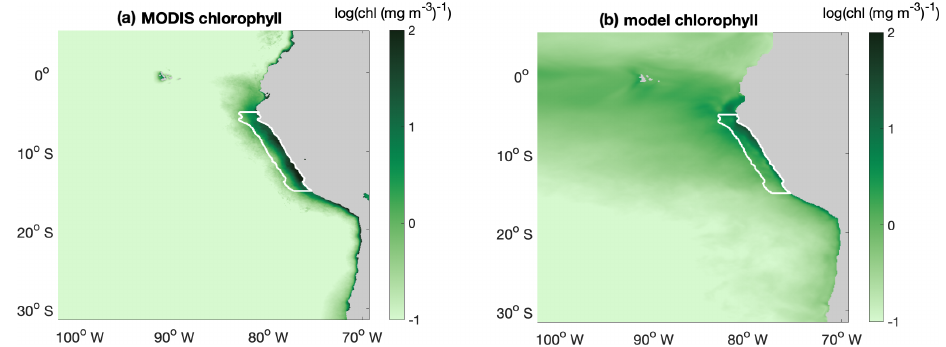
Figure B1. Annual mean surface chlorophyll concentration (in log ( chl ( mgm − 3 ) − 1 )) distribution of (a) MODIS and (b) CROCO–BioEBUS. White lines highlight the focus region.